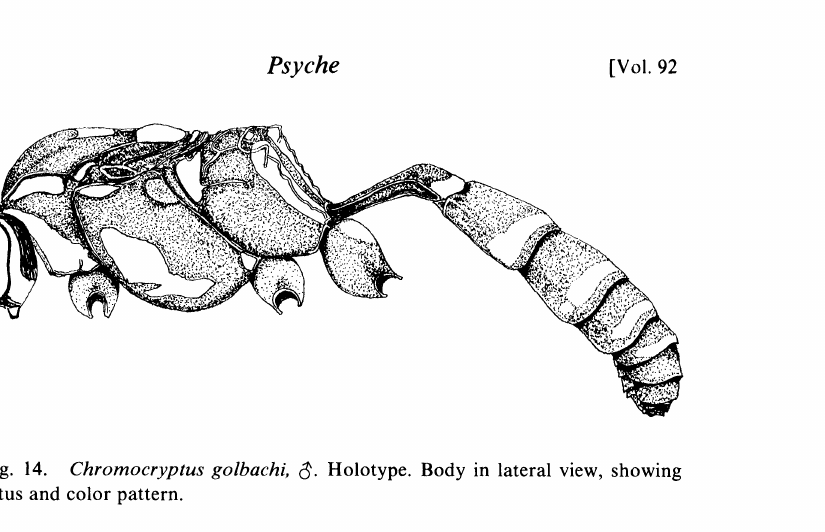
Fig. 14. Chromocryptus golbachL (3. Holotype. Body in lateral view, showing habitus and color